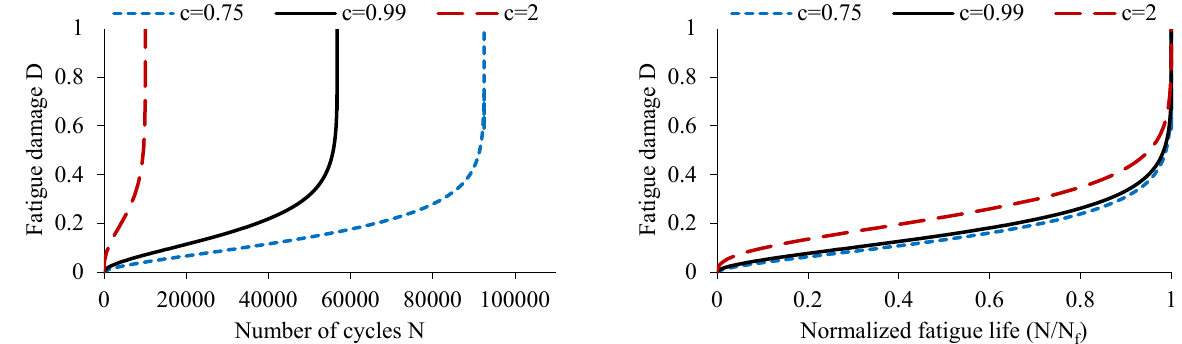
Modifying the parameter ( ) c alters the evolution and kinetics of fatigue damage, as